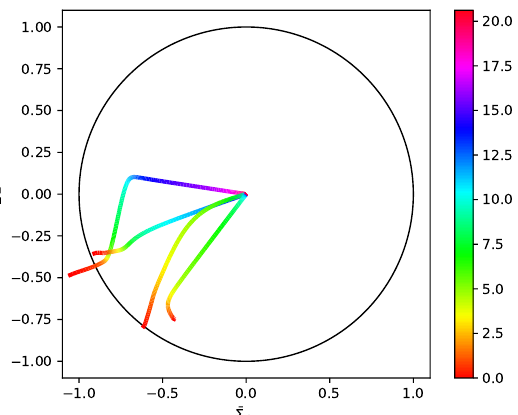
Figure 2. The state space orbit for a worldline at four different spatial points. Each point is located in one of the initially inhomogeneous regions shown in Figure 1. The circle corresponds to the (vacuum) Kasner solution and the center of the circle corresponds to a smooth Friedmann-Robertson-Walker (FRW) universe. The color coding along each of the four state space orbits indicates the number of e -folds of contraction of the Hubble radius | H − 1 | according to the color bar on the right. Although the four points start with different initial conditions and follow different trajectories that reach the center at different times, all converge to the flat FRW state after only 20 e